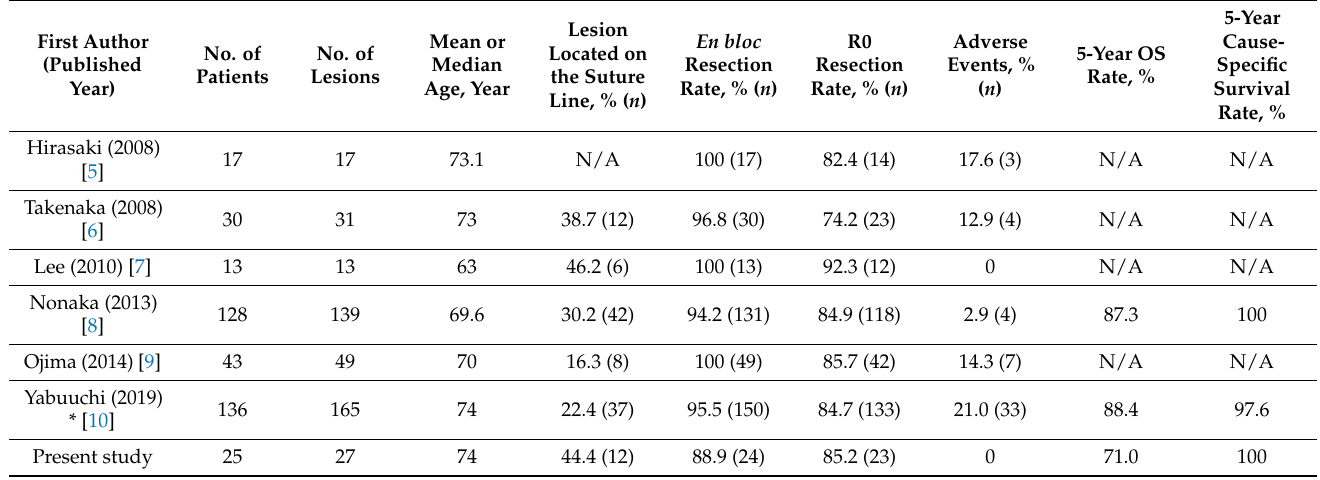
Table 7. Summary of previous